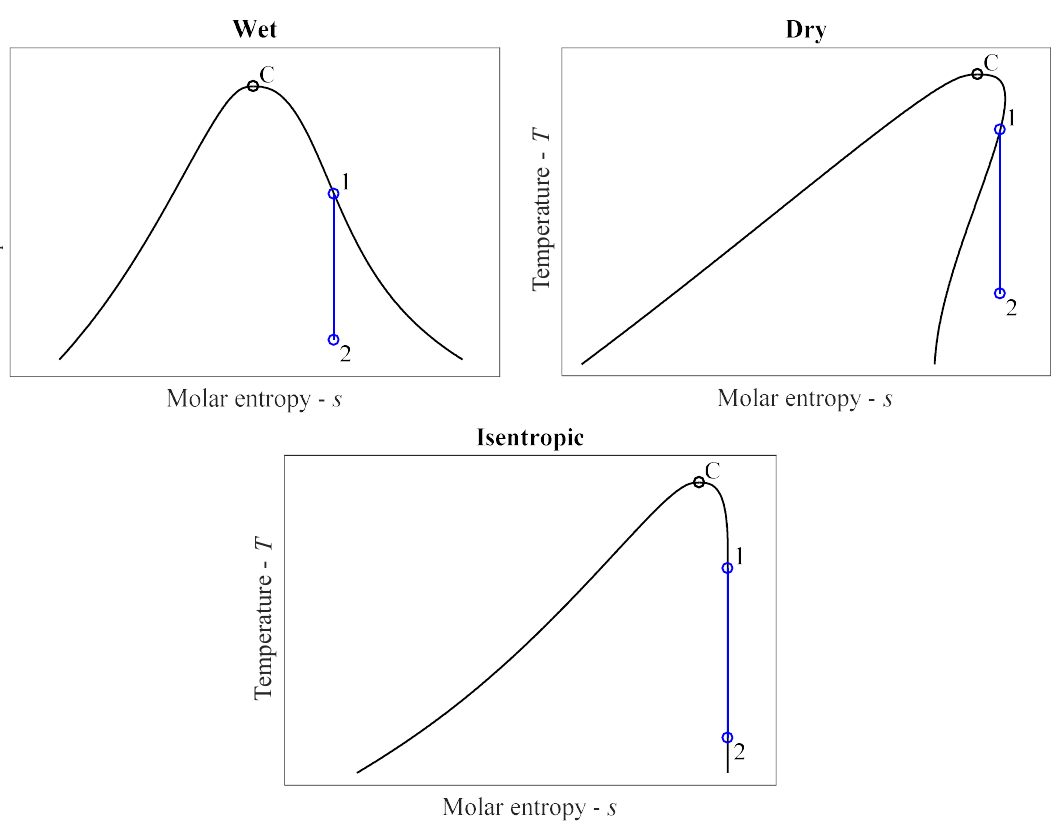
Figure 1. Traditional categorization: wet, dry, and isentropic. Curves represent saturated states. One-phase states are located above the saturation curves (liquid states: low-entropy side; vapor states: high-entropy side). Two-phase states (liquid + vapor) are located below the saturation curve. Lines 1 and 2 represent isentropic expansion processes (see corresponding text).